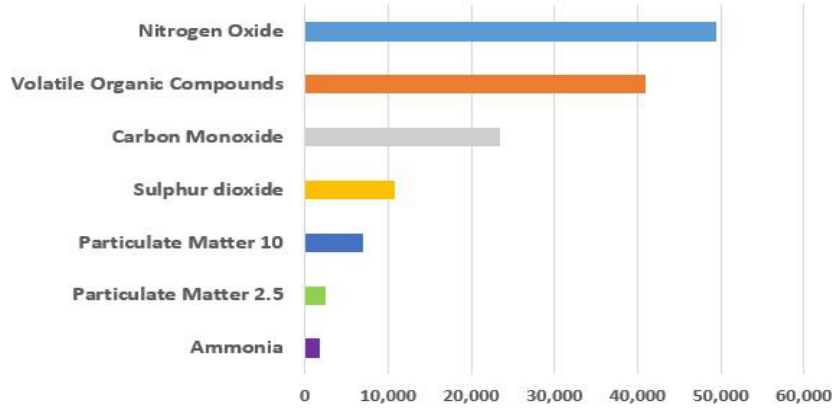
Figure 2. Air pollutant emission quantity in Busan Metropolitan City 2016, (unit: Tons).